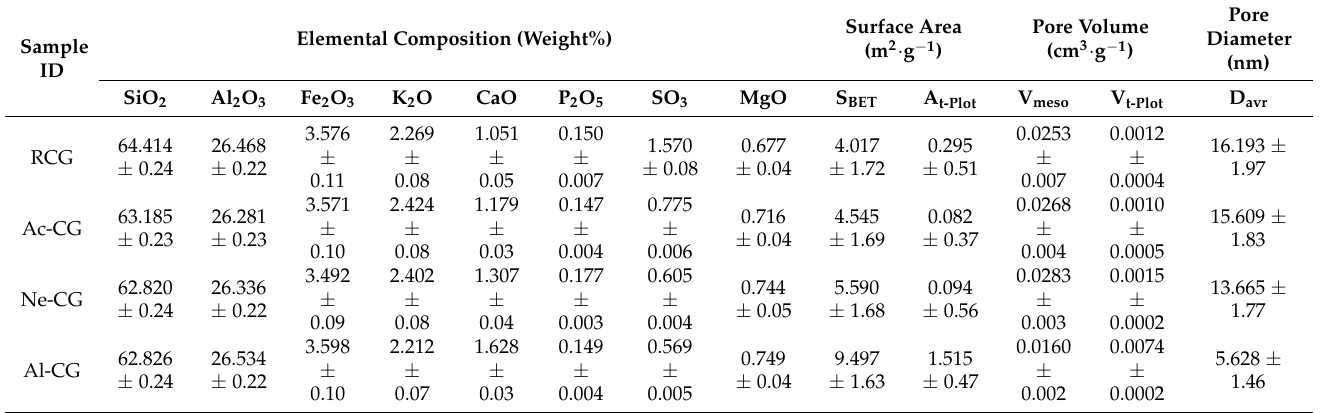
Table 1. Physiochemical properties of coal gangue